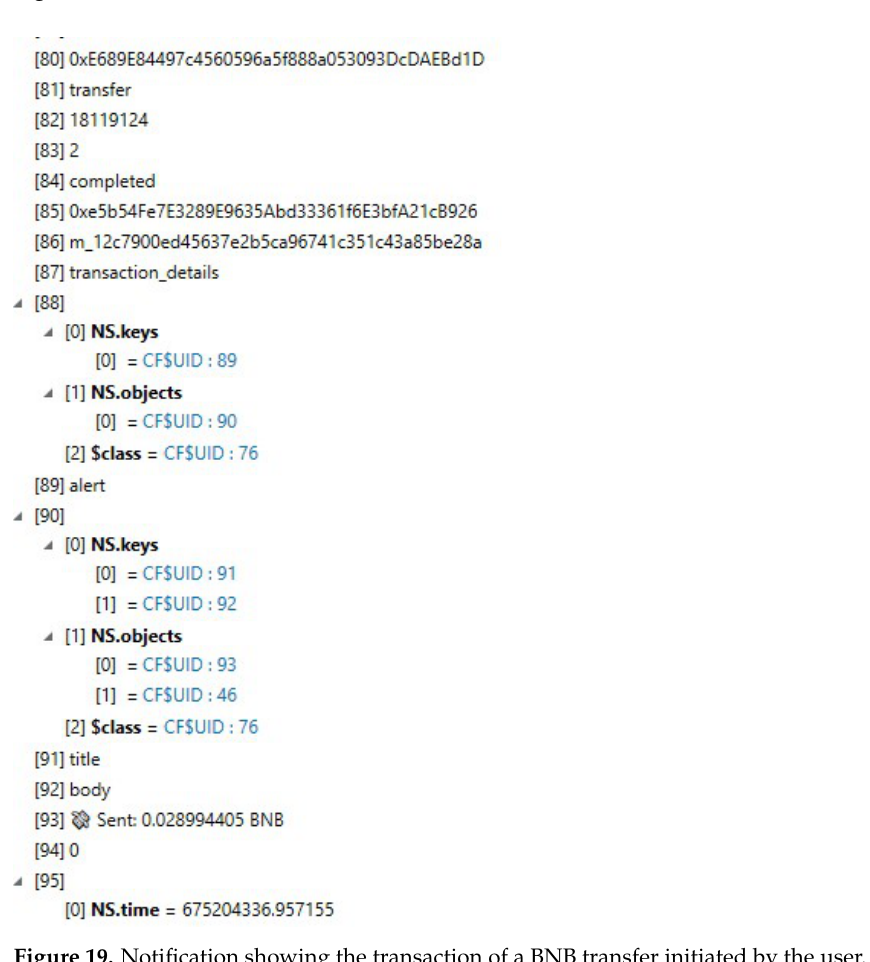
Figure 19. Notification showing the transaction of a BNB transfer initiated by the